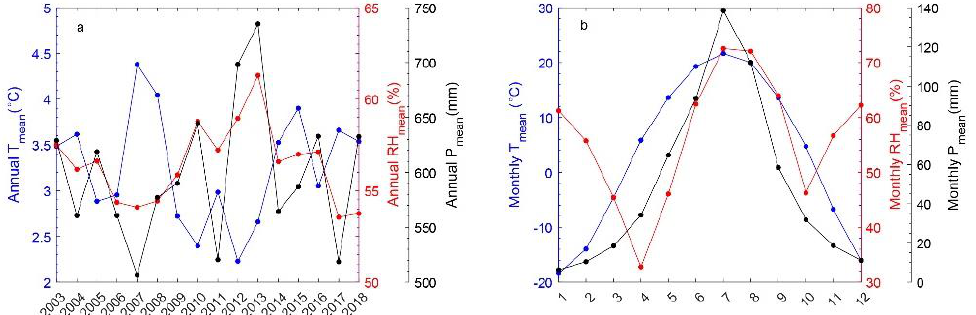
Figure 12. ( a ) Annual and ( b ) monthly mean temperature (T mean ), relatively humidity (RH mean ), and accumulated precipitation (P mean ) during 2003 – 2018.